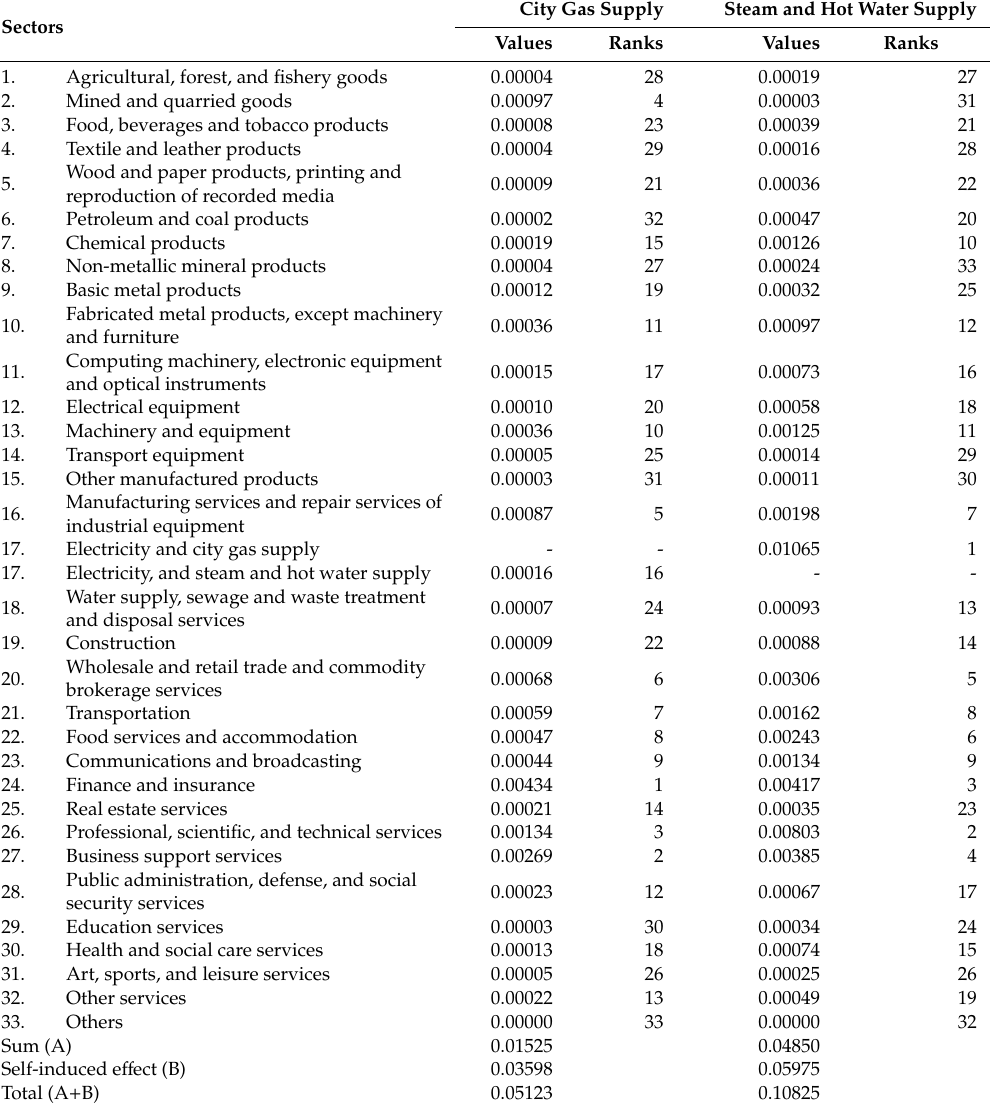
Table 4. Wage-inducing e ff ects of steam and hot water supply and city gas supply